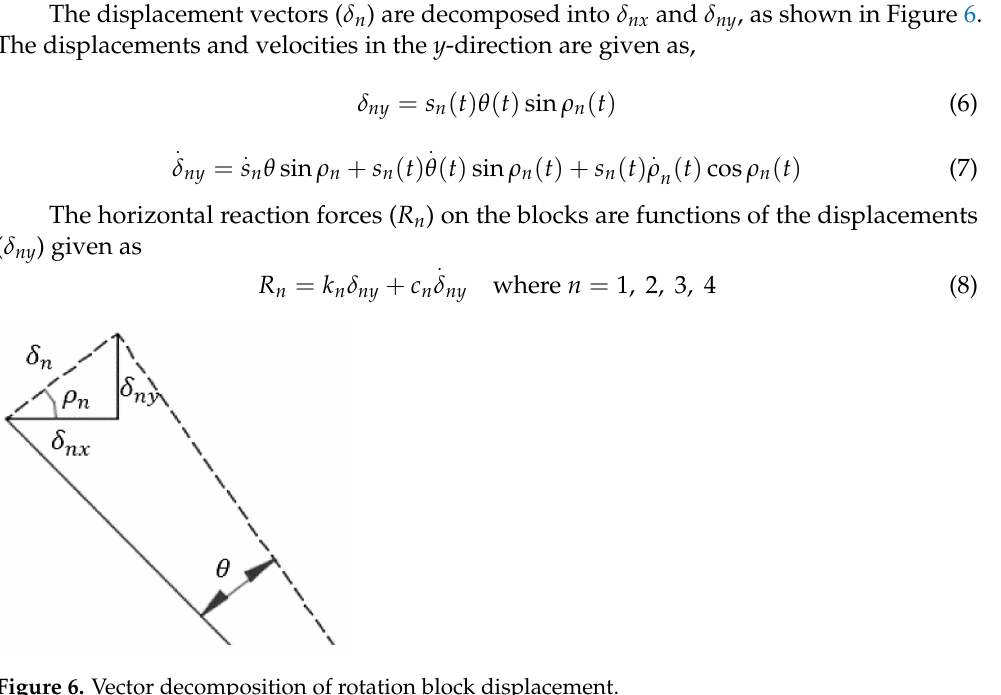
Figure 6. Vector decomposition of rotation block